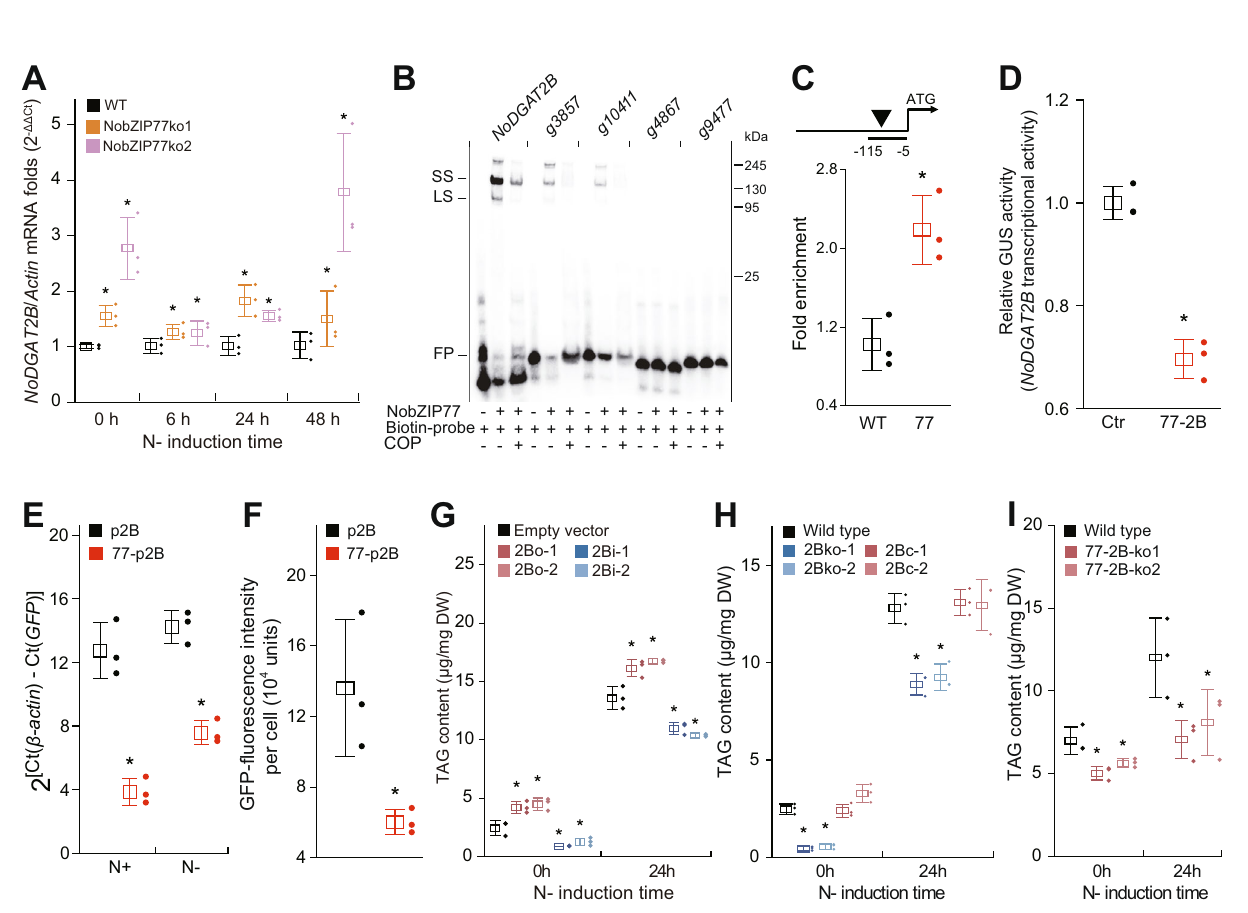
Fig. 2 NobZIP77 inhibits NoDGAT2B transcription by binding to its promoter. A Transcript level of NoDGAT2B in WT, NobZIP77ko-1, and NobZIP77ko-2 at 0 h, 6 h, 24 h, and 48 h under N − . WT, wild type. B EMSA validation of speci fi c binding between NobZIP77 and the promoters of its targeted genes (i.e., NoDGAT2B , g3857 , and g10411 ). g3857 , TAG-lipase ; g10041 , lipase ; g4867 , hsp70 ; g9477 , actin . Unlabeled DNA of the promoters in 100-fold molar excess was treated with the NobZIP77 protein. LS, lower shift complex (a 1:1 complex of DNA and the bZIP dimer); SS, super shift complex; FP, free-DNA probe; COP, competitor oligonucleotide primer. The experiments were repeated three times. C ChIP-qPCR analysis of NobZIP77 binding to the promoter of NoDGAT2B (p NoDGAT2B ) in vivo. In p NoDGAT2B , the region used for ChIP-qPCR is marked (transverse line, top panel). The bZIP binding motif is indicated as arrowheads. The numbers in fragment indicate positions of the nucleotides at the 5 ′ or 3 ′ end of the fragment relative to the translation start site. β -actin was used as an internal reference gene. WT, wild type; 77, gfp : NobZIP77 -overexpression line. D The enzymatic activities of glucuronidase (GUS) between NobZIP77 -p NoDGAT2B co-transfected or p NoDGAT2B transfected Arabidopsis leaf protoplasts. The luciferase (LUC) was used as a control. Ctr, p NoDGAT2B transfected Arabidopsis leaf protoplasts; 77-2B, NobZIP77 -p NoDGAT2B co-transfected Arabidopsis leaf protoplasts. E Comparison of GFP transcript level between the NoDGAT2B -promoter transformed (p2B) and the NobZIP77- NoDGAT2B -promoter transformed (NobZIP77-p2B) lines of N. oceanica , under N + or N − (24 h). F Quanti fi cation of GFP fl uorescence (average fl uorescence intensity per cell) in the p2B and NobZIP77-p2B lines. G TAG content of the NoDGAT2B overexpression and knockdown lines in N. oceanica . H TAG content of the NoDGAT2B knockout and complementation lines. I TAG content of the NobZIP77 and NoDGAT2B double-knockout lines. Data are represented as mean ± SD ( n = 3 biologically independent samples). *: signi fi cant change ( p ≤ 0.05) by one-sided Student ’ s t -test versus WT ( A , C , H, I ), LUC ( D ), p2B ( E , F ), or EV ( G ). Source data are provided as a Source data fi NoDGAT2B is a key target of NobZIP77 . To identify the binding sites of NobZIP77, a phylogenomic footprinting pipeline was developed via MERCED 24 , revealing seven LRGs (Supple- mentary Data 1). These LRGs encode multiple TAG/FA metabolism-related enzymes, including DGAT, phosphatidic acid